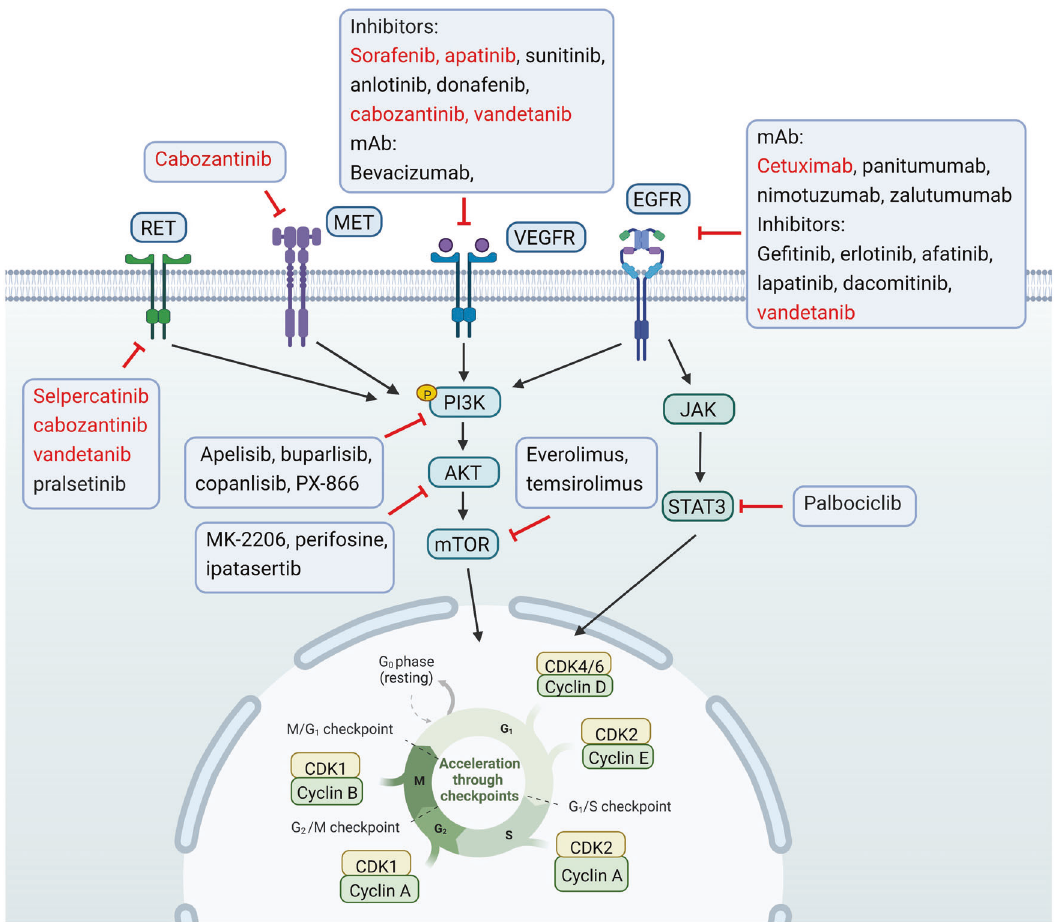
Fig. 6 Comprehensive understanding and inhibitor direction for targeting signaling pathways in clinical trials in HNC treatment. EGFR epidermal growth factor receptor, MET mesenchymal – epithelial transition factor, AKT serine/threonine-speci fi c protein kinase, mTOR mammalian target of rapamycin, CDK cyclin-dependent kinase, VEGF vascular endothelial growth factor, JAK jenus-activated kinase, STAT signal transducer and activator of transcription, mAb monoclonal antibody, RET rearranged during transfection, p